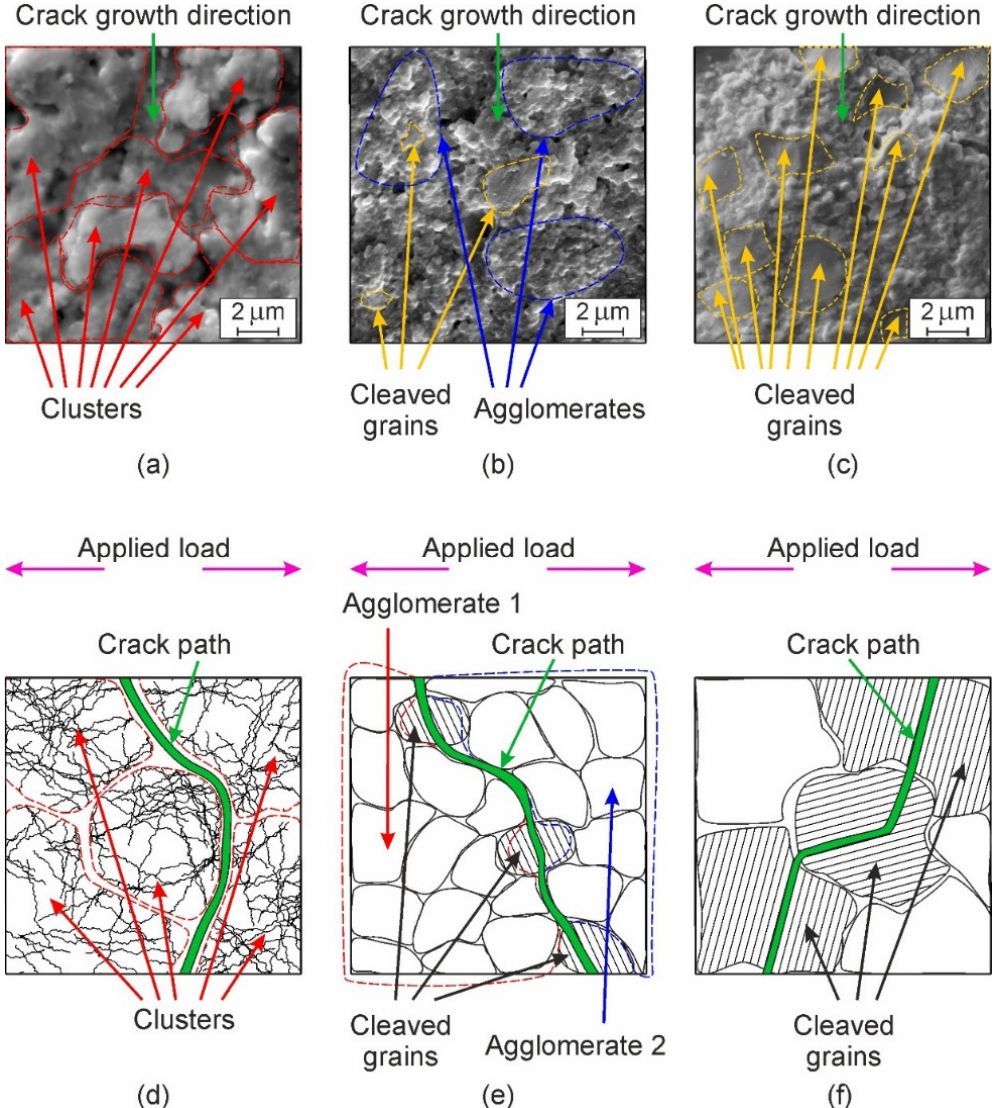
Figure 13. Microstructure evolution in ceramics in relation to their crack-growth resistance: ( a – c ) SEM images of characteristic fracture micromechanisms and ( d – f ) modeling diagrams for corresponding micromechanisms; the diagrams ( d – f ) exhibit crack propagation paths for characteristic fracture patterns under load applied in the direction shown by arrows; the arrows also indicate some microstructure components (cleaved grains, clusters, and agglomerates of fine grains).